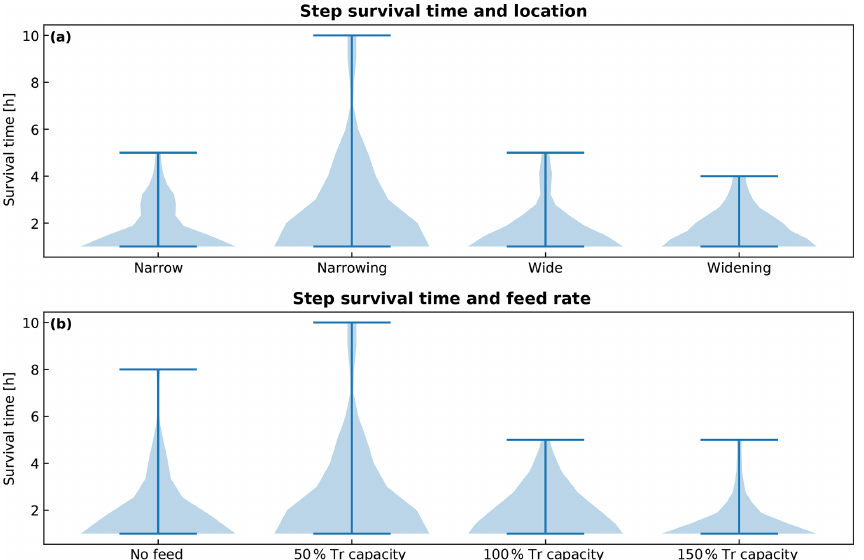
Figure 9. Violin plots of step survival times as a function of (a) step location and (b) sediment feed rate, with no-feed experiments shown for